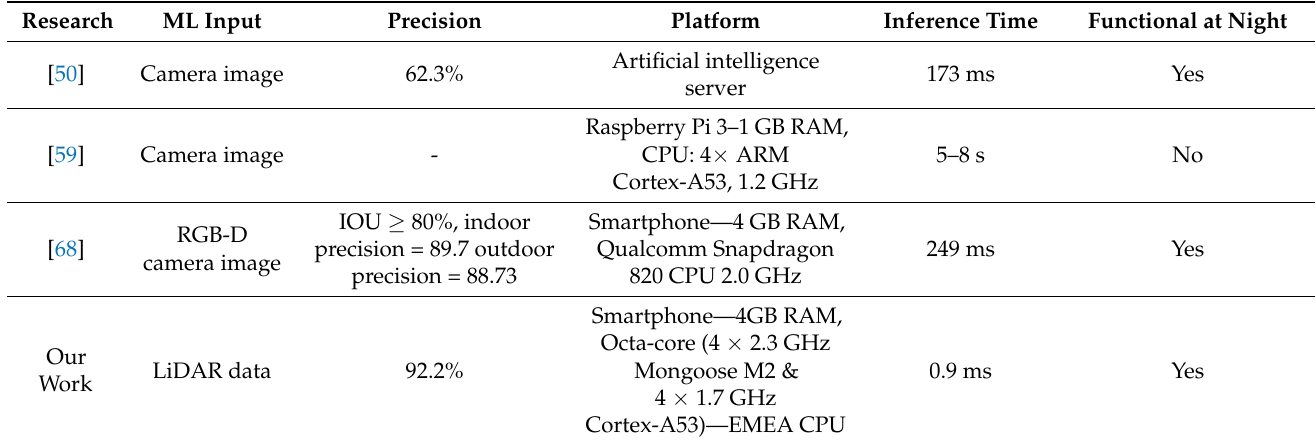
Table 5. Comparison of the results with similar ML